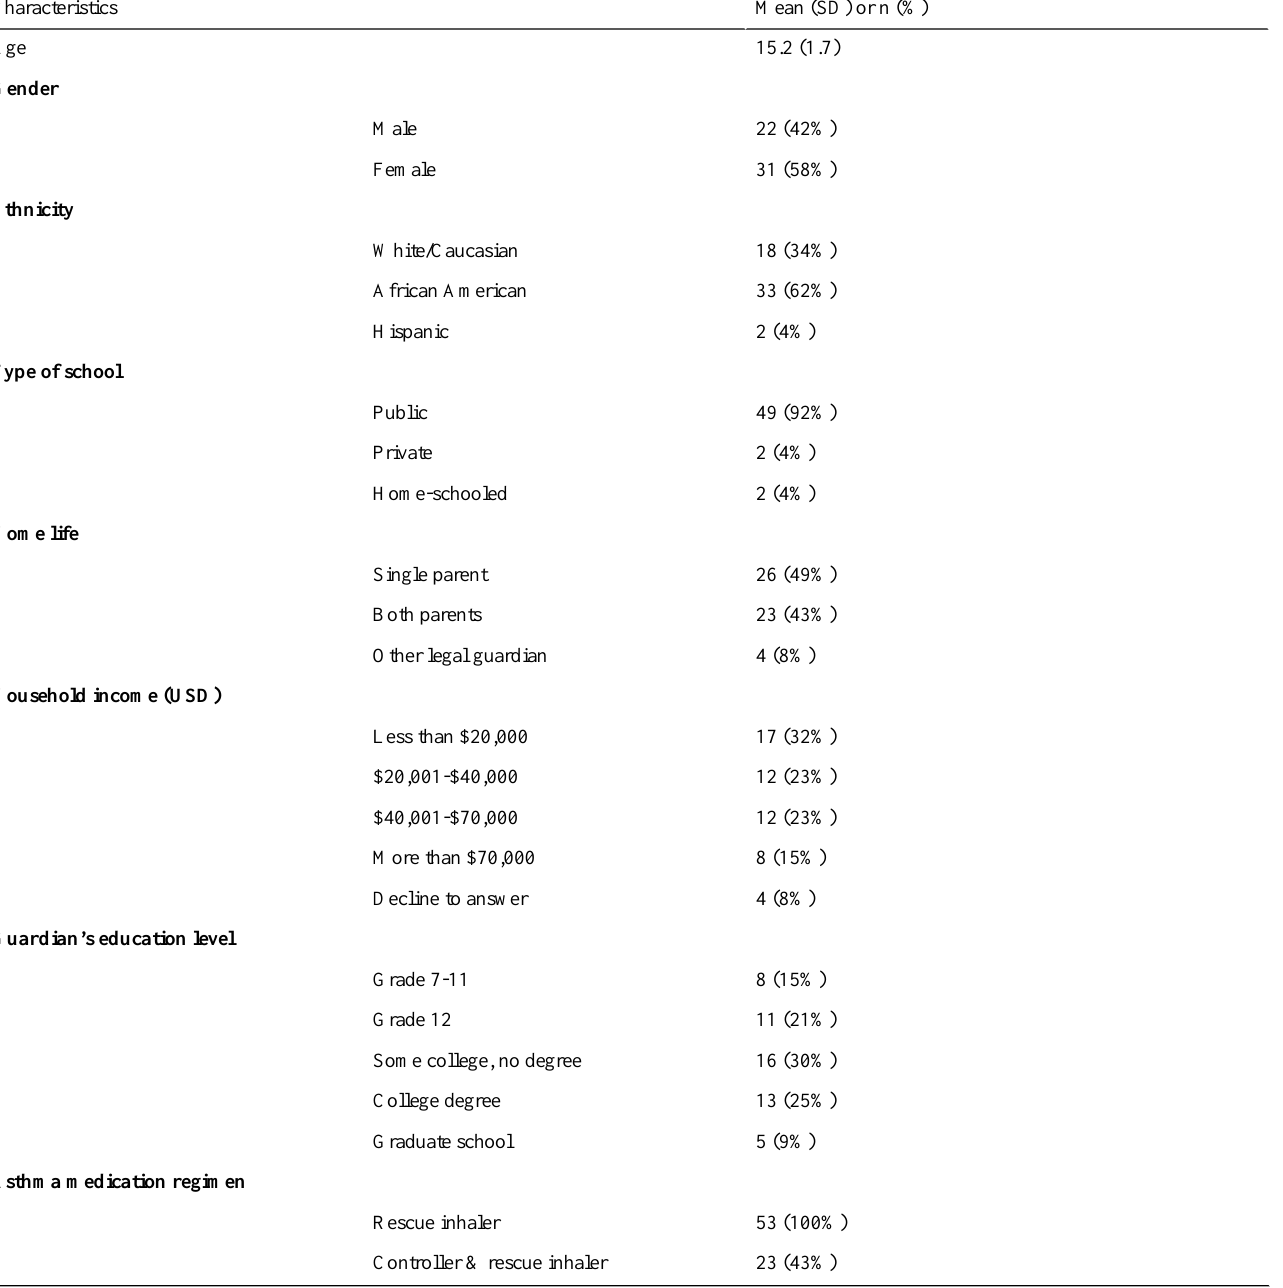
Table 1. Characteristics of the sample